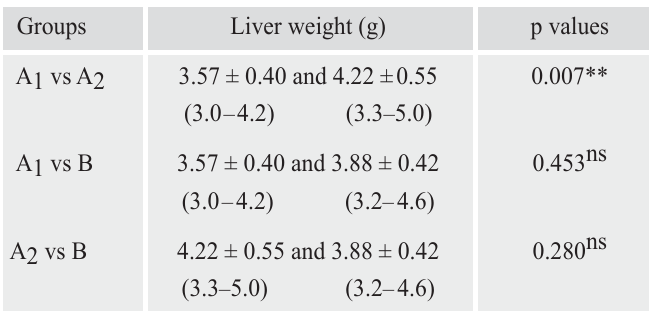
Table II: Comparison of liver weight of rats between